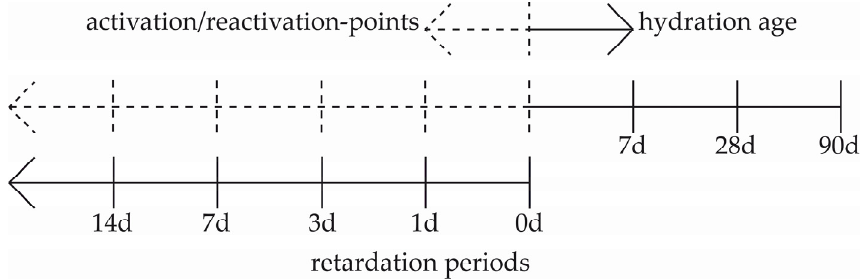
Figure 1. Timescale of the retardation periods (0–28 days), the points of activation/reactivation (Ac1, Ac2) and the ages of hydration (7–90 days). Table 1. Chemical composition and physical properties of ground granulated blast ‐ furnace slag (GGBFS).